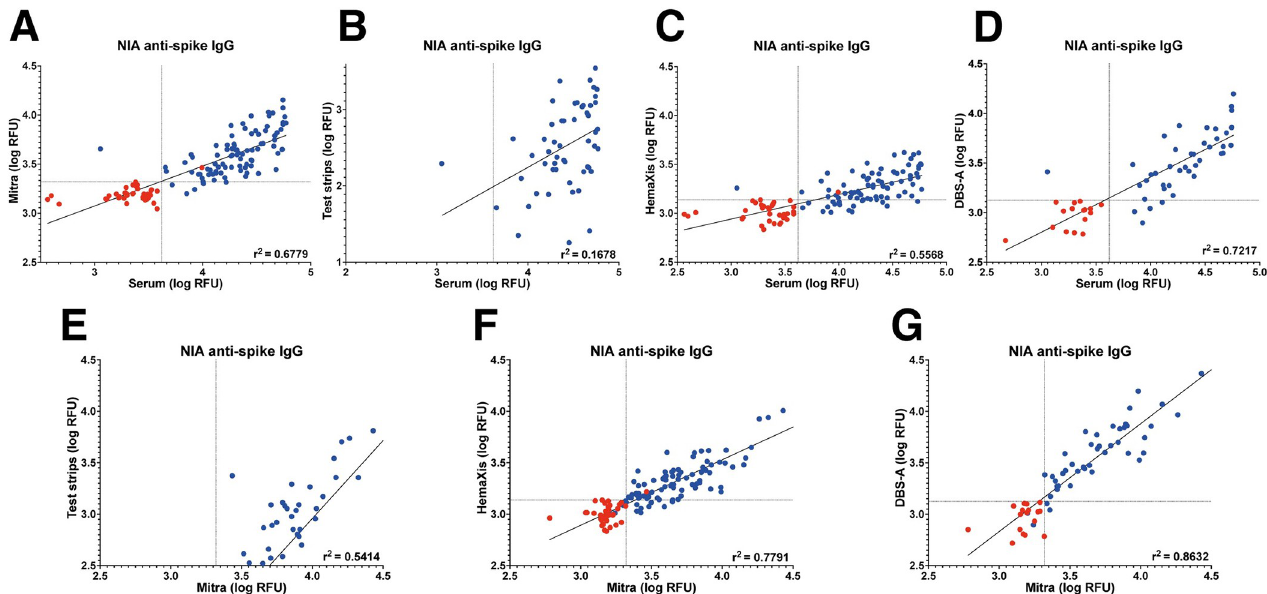
Fig 4. NIA serum and microsampling comparison. Comparison of serum at 1:8 dilution and samples obtained by microsampling tested on NIA. Samples from SARS-CoV-2 negative and SARS-CoV-2 positive participants are labeled red and blue, respectively. Comparison of serum samples with A) Mitra, B) (glucose) test strips, C) HemaXis, and D) HemaXis with automated extraction (DBS-A). Serum samples with signal above 59000 RFU were removed from the plot and linear regression. Comparison of Mitra with E) glucose test strips, F) HemaXis, and G) HemaXis with automated extraction (DBS-A). In panels B) and F), samples with negative signals were excluded. The samples from SARS-CoV-2 negative participants were not included in the linear regression.